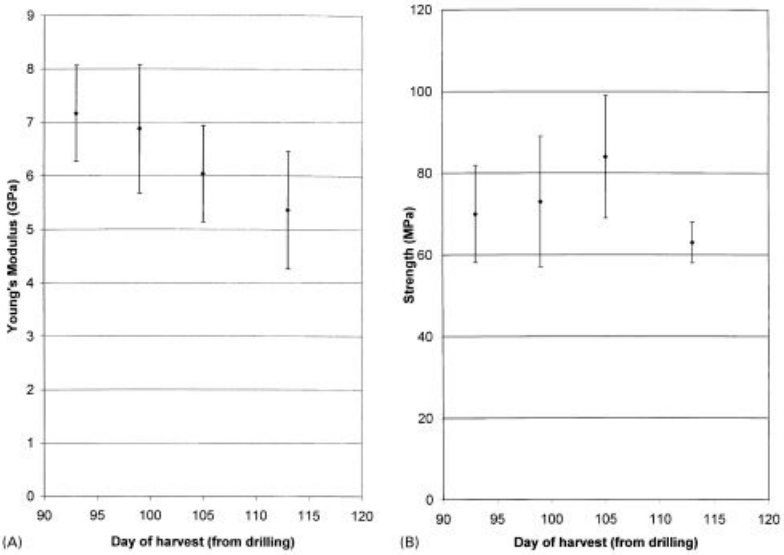
Figure 4. ( A ) Showing the difference in Young’s Modulus (in GPa) of hemp fiber against the days of harvest. ( B ) Showing the change in tensile strength (in MPa) as a function of harvest time. Reprinted/adapted with permission from Hepworth DG et al. (2000) [117].